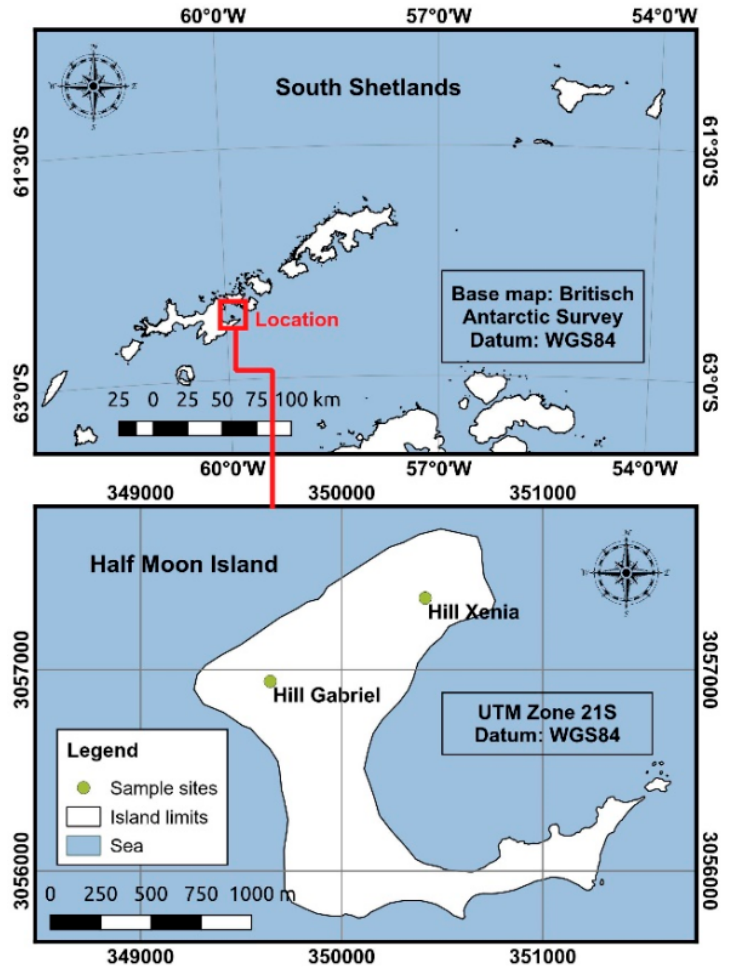
Figure 1. Location of Half Moon Island in the South Shetland archipelago in maritime Antarctica showing the sites where leaf samples of Deschampsia antarctica were collected (green dots).